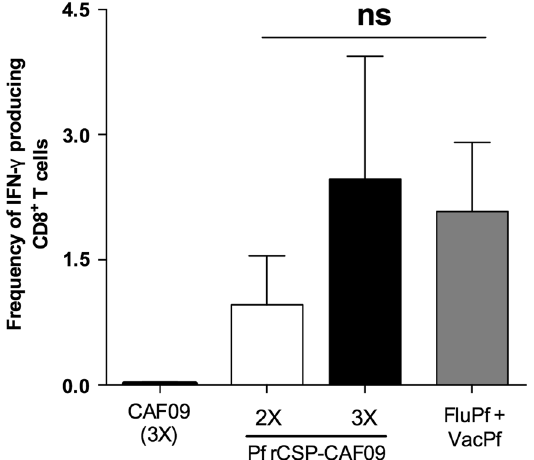
Fig. 2 Antigen-speci fi c CD8 + T-cell responses induced by Pf rCSP- CAF09 immunizations. CD8 + T-cell responses were assessed in spleens of mice 10 days after the last immunization with either two or three doses of Pf rCSP-CAF09 ( n = 3 per group). Cellular responses were compared to those induced by a prime-boost regimen using recombinant in fl uenza (FluPf) and vaccinia (VacPf) viruses expressing selected sequences of the P. falciparum CSP ( n = 3). Mice immunized with CAF09 (3×) alone did not produce measurable T-cell responses. The production of IFN- γ by CD8 + T cells was assessed in ex vivo stimulation assays using LM1 cells pulsed with the synthetic peptide DYENDIEKKI. Bars represent means ± SEM. Abbreviations: ns , not signi fi cant; IFN- γ , interferon-gamma; SEM, standard error of the